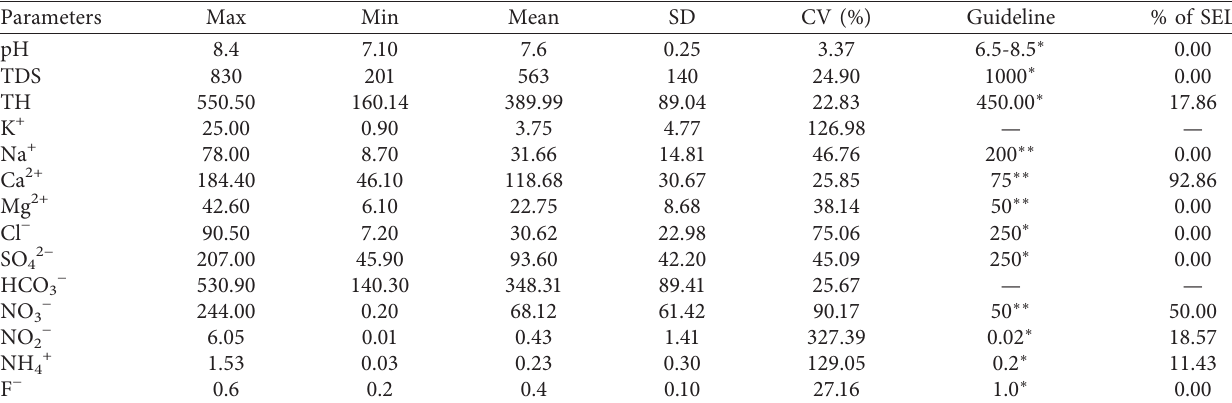
Table 2: Statistical results of hydrochemical parameters and drinking water